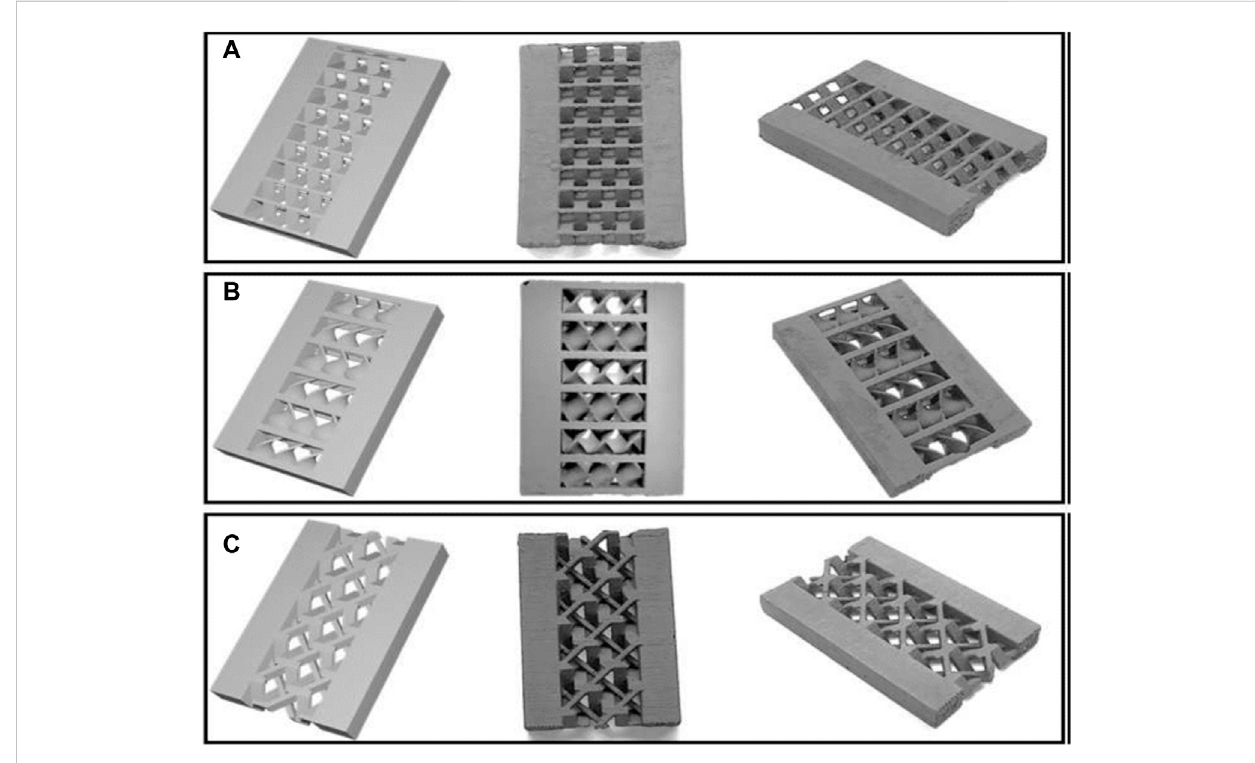
FIGURE 7 Structures of 3D electrodes: (A) RLPD, (B) Kenics, and (C) SMX electrodes. Reproduced from De Wolf et al. (2022), with permission from ChemElectroChem, Wiley Online